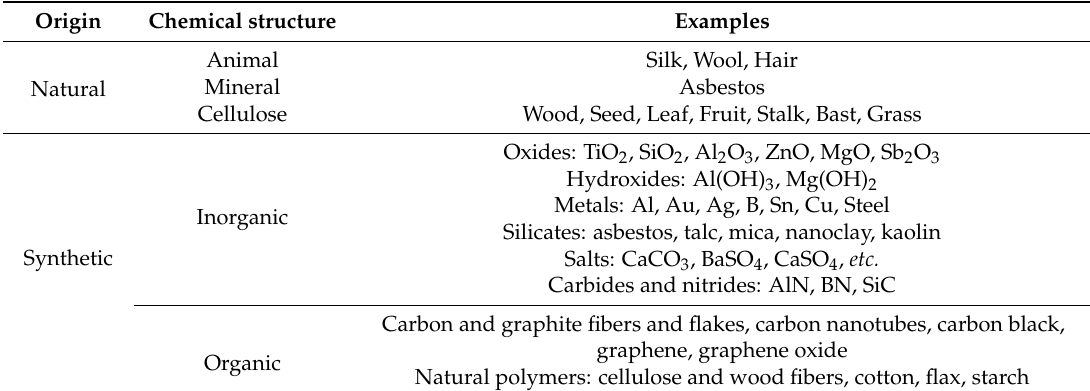
Table 1. Examples of different types of fillers (Adapted table from [54]). Origin Chemical structure Examples Silk, Wool,